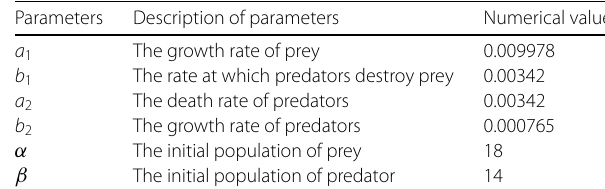
Table 1 Values of parameters taken for Case I